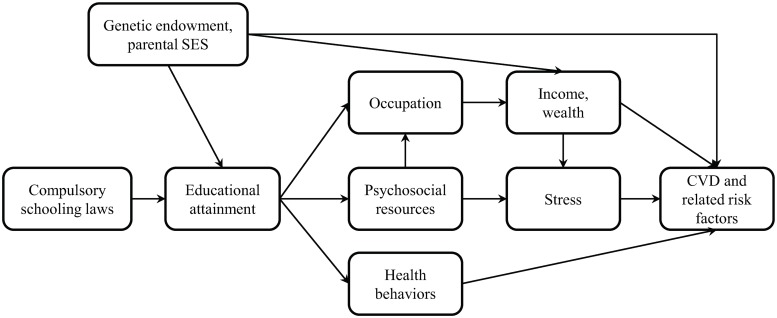
Conceptual model linking educational attainment and CVD.CVD, cardiovascular disease; SES, socioeconomic status.